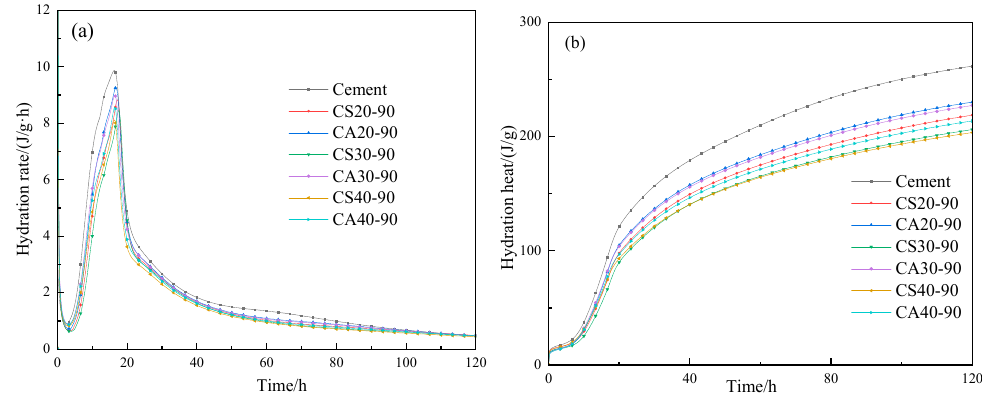
Figure 5. The ( a ) hydration rate and ( b ) hydration heat of the copper slag powder-cement composite systems at 20 °C.